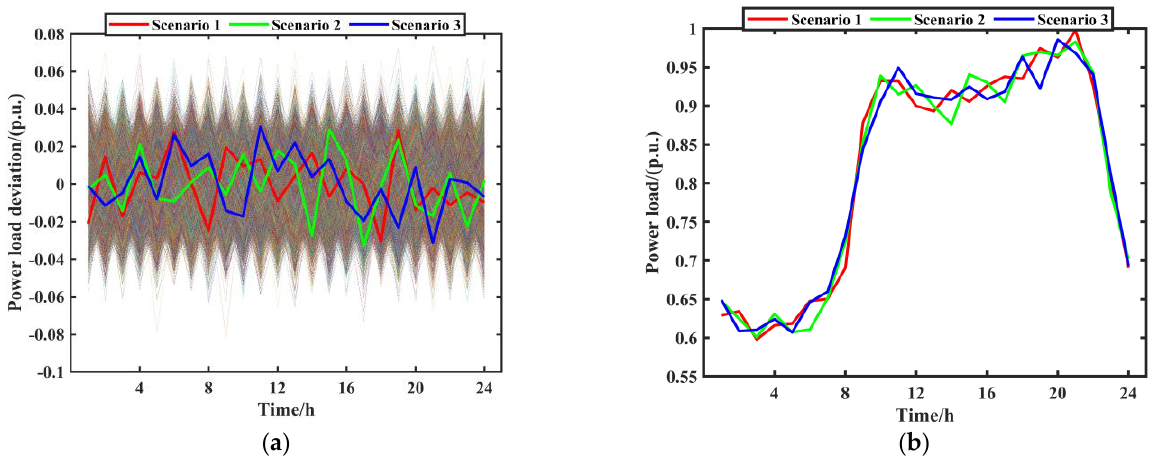
Figure 4. ( a ) Power load deviation before and after the scenario reduction; ( b ) power load of reduced scenarios. Table 1. Parameters of generators.